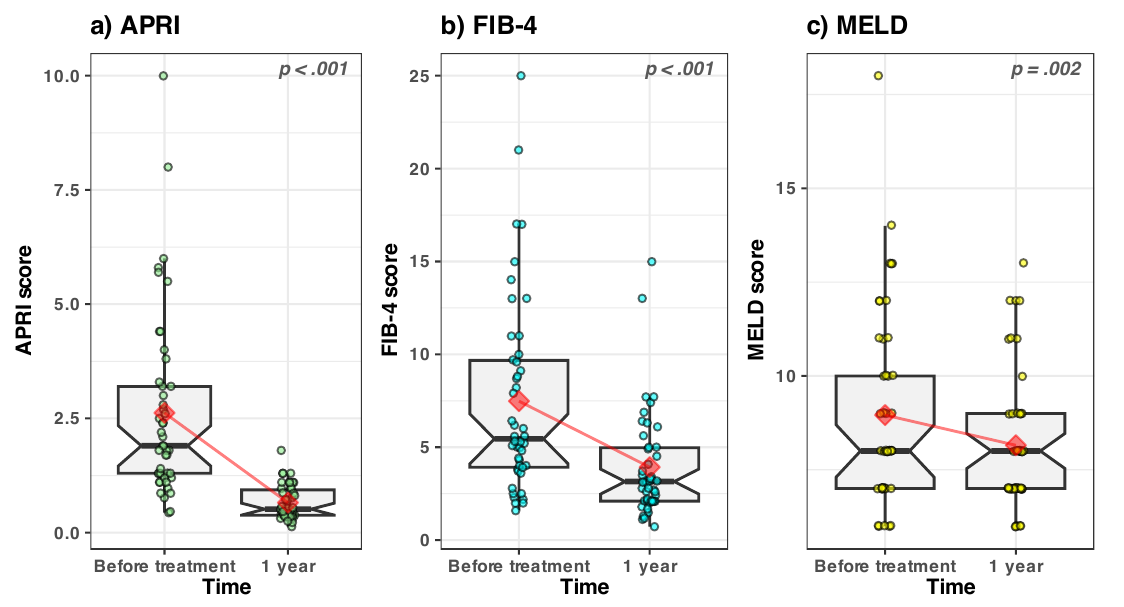
Figure 3. Boxplots of the APRI, MELD and FIB-4 score values vs. time. The values recorded from each patient are represented by the dots (slightly jittered for clarity). The median value is represented by the horizontal thick black line. The lower and upper hinges correspond to the first and third quartiles (the interquartile range). The whiskers extend to 1.5 times the interquartile range; data points outside the whiskers are potential outlier values. The notches extend to the 95% confidence intervals for comparing the medians. The mean value of each subgroup is represented by the red diamond; the connecting red lines are meant as a guide to the eye to spot the